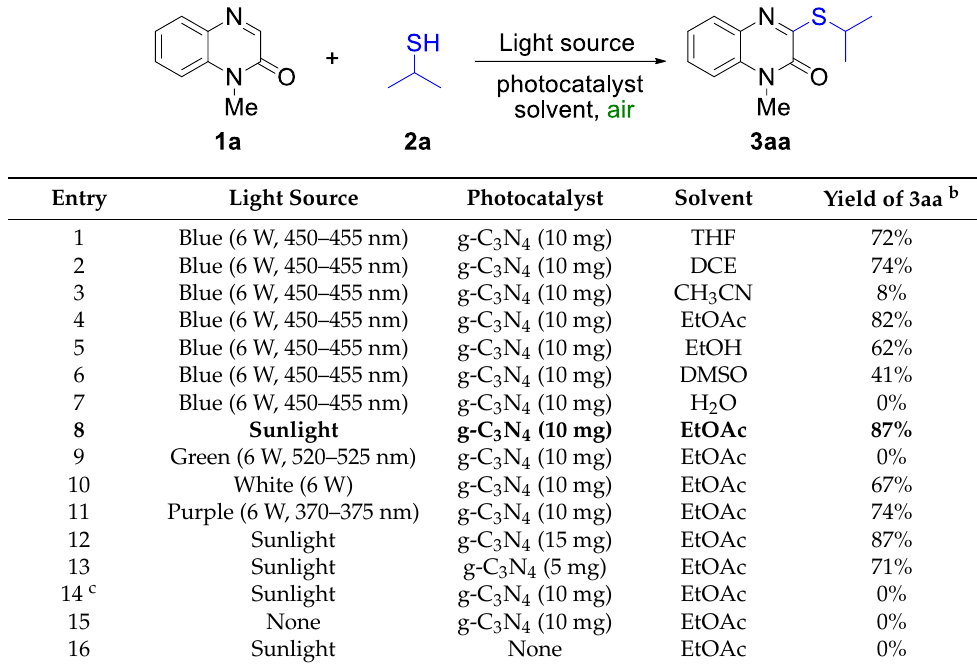
Table 1. Optimization of reaction conditions a .